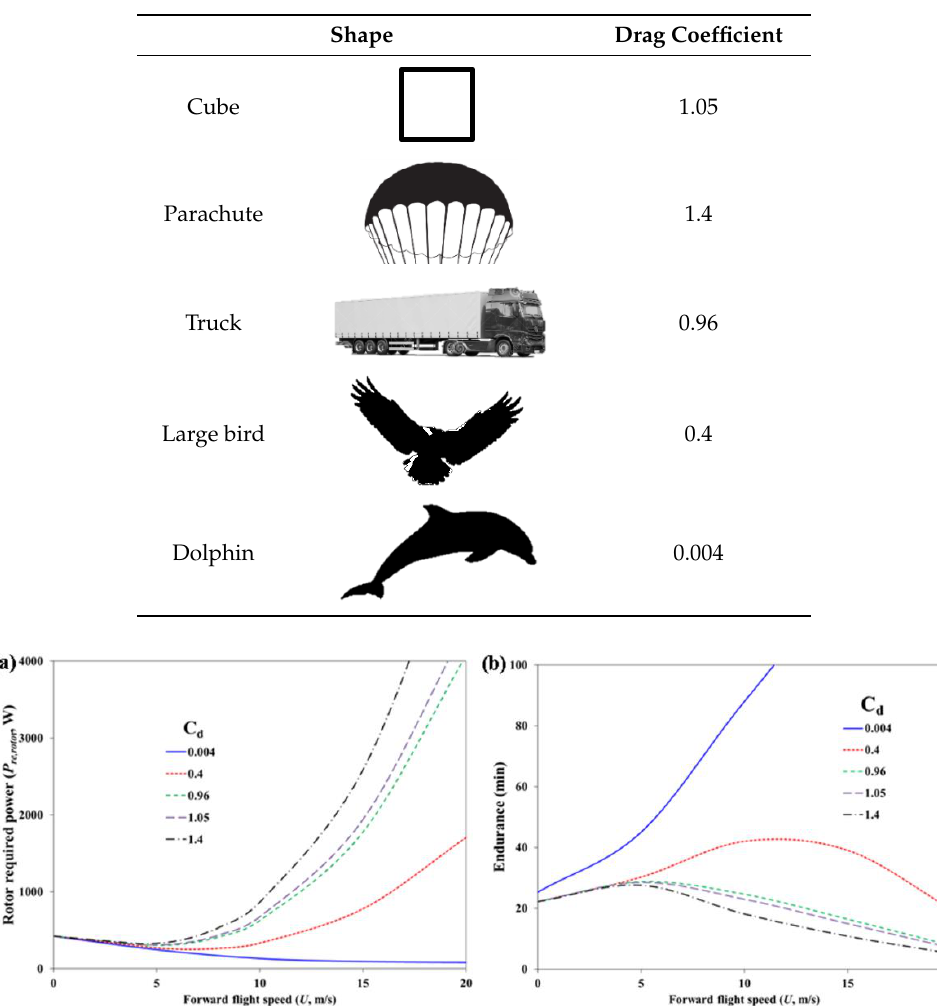
Figure 7. Required rotor power, induced power and drag overcoming power with various flight speed. Induced velocity is also represented. W is 14 kg, C d is 0.96, C 0 is 16,000 mAh and V 0 is 49 V.